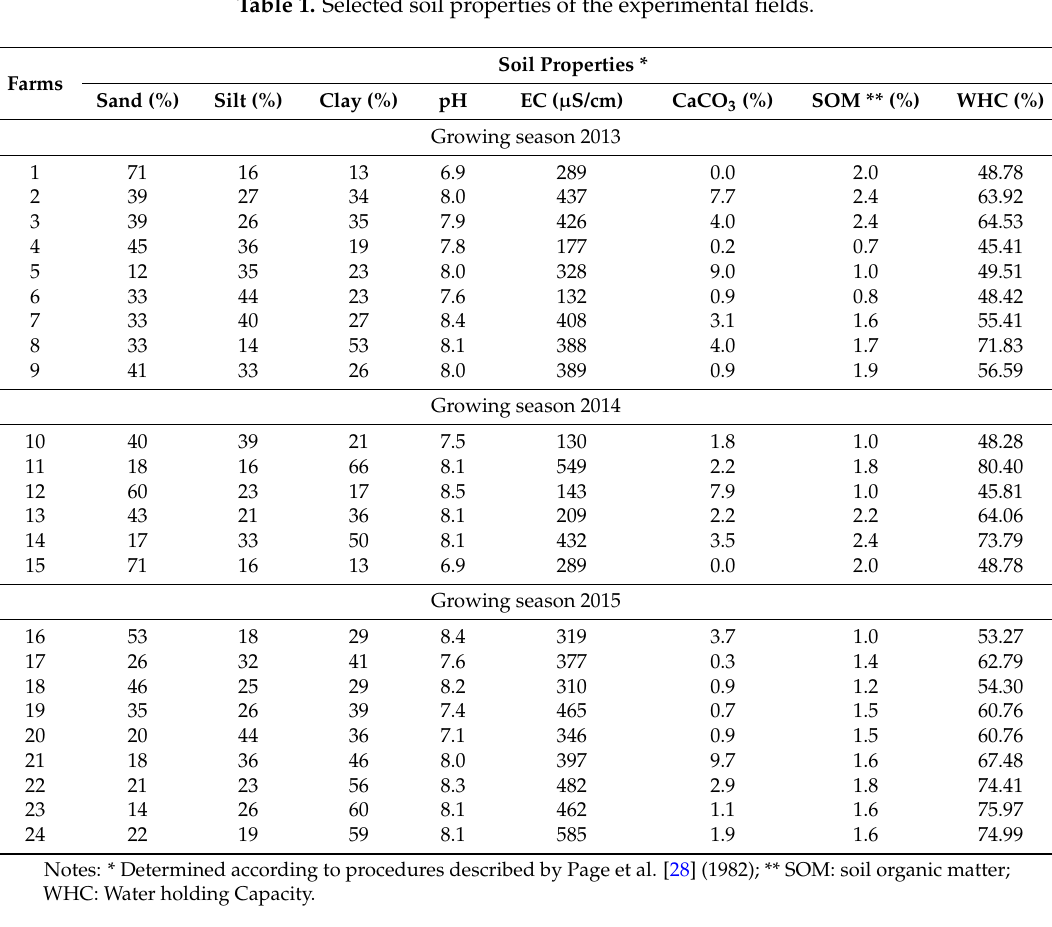
Table 1. Selected soil properties of the experimental fields.